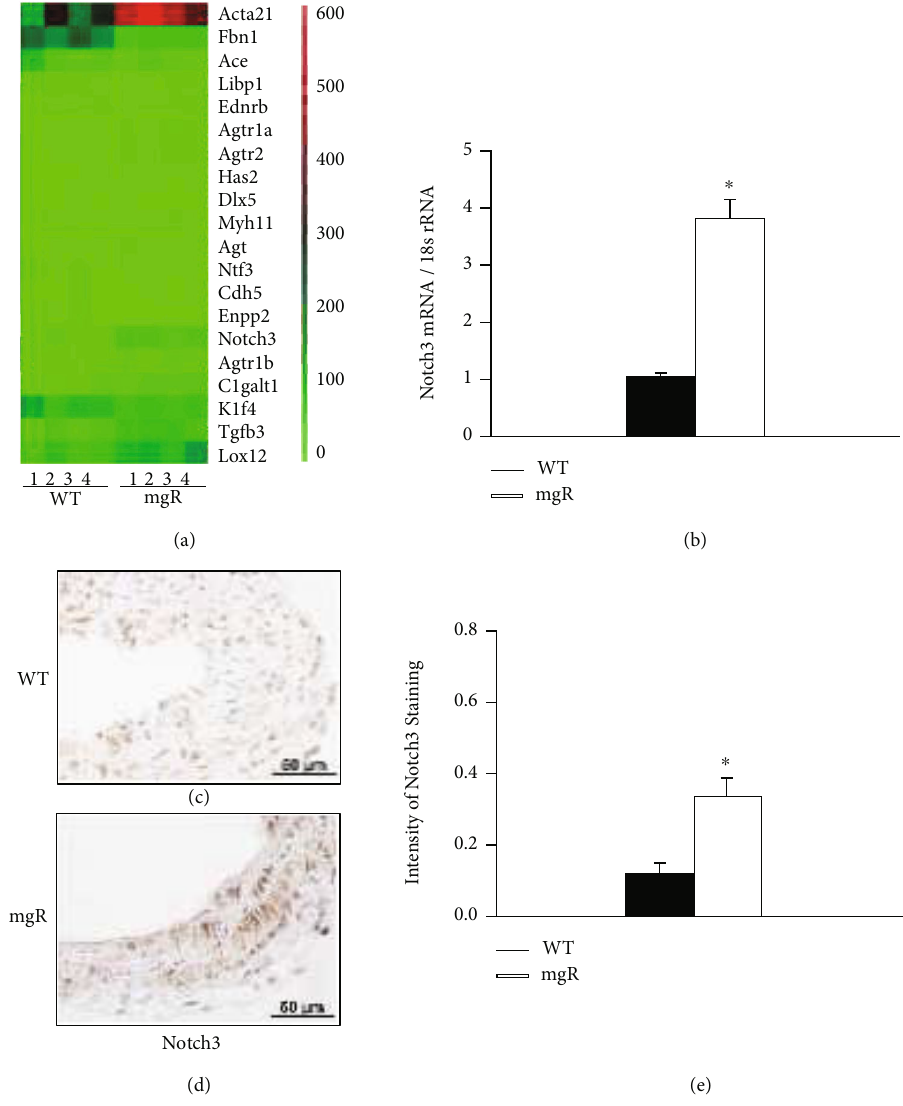
Figure 1: Genes were di ff erentially expressed in the aorta of WT and Fbn1 mgR/mgR (mgR) mice including Notch3, Fbn1, and α -actin. (a) Heatmap of the di ff erentially expressed genes in the aorta of WT and mgR mice at PD28 ( n = 4 /group) was generated using data from RNA-Seq analysis. (b) Notch3 mRNA expression in the aorta of WT ( n = 8 ) and mgR ( n = 8 ) mice at PD28 was analyzed by real-time PCR. The bar graph (b) shows relative expression of Notch3 and 18s rRNA. Immunohistochemical staining of Notch3 in the aortic sections from (c) WT and (d) mgR mice at PD28 ( n = 4 – 6/group), respectively. Positive staining is shown in brown (DAB). Notch3- positive cells were quantitated by De fi niens Tissue Studio software. Brown chromogen intensity is shown in (e) bar graph ( n = 4 – 6/ group). ∗ P < 0 : 05 compared to WT controls; Student ’ s t